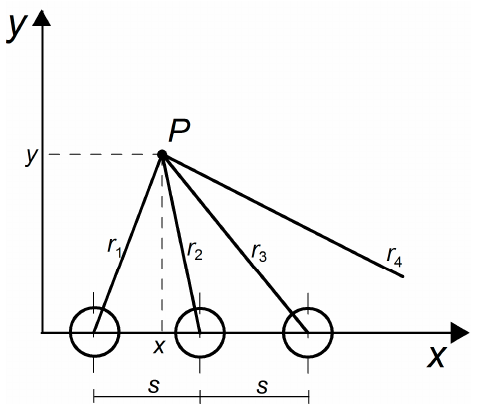
Figure 2. The parallel pipes system of a ground heat exchanger.